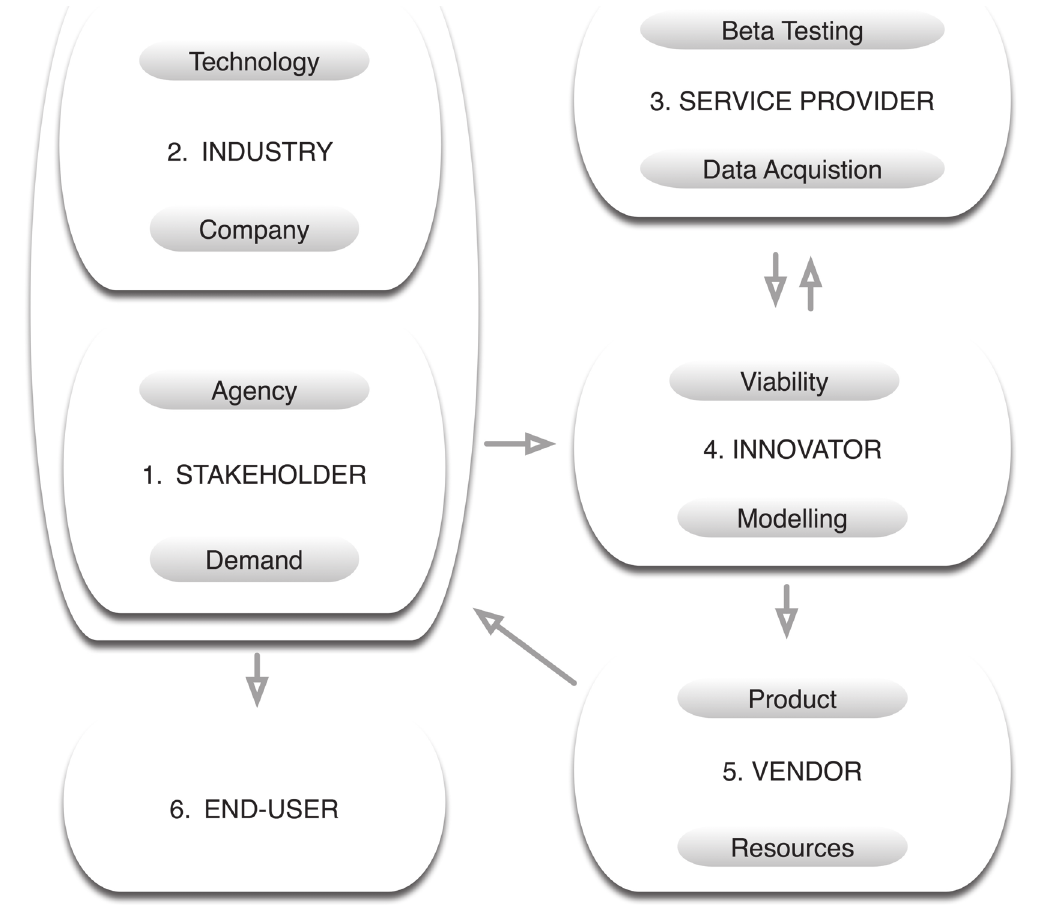
Figure 1. A business or enterprise model commonly used in